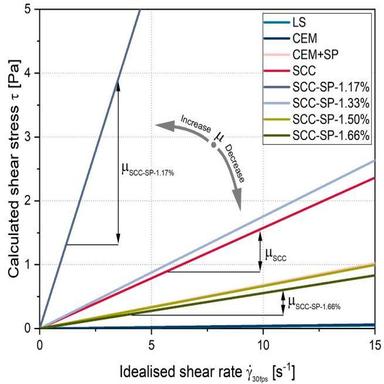
A-test method viscosity determination results, excluding yield stress, represented as a Newtonian fluid, enabling clearer visualisation of the differences in plastic viscosity.